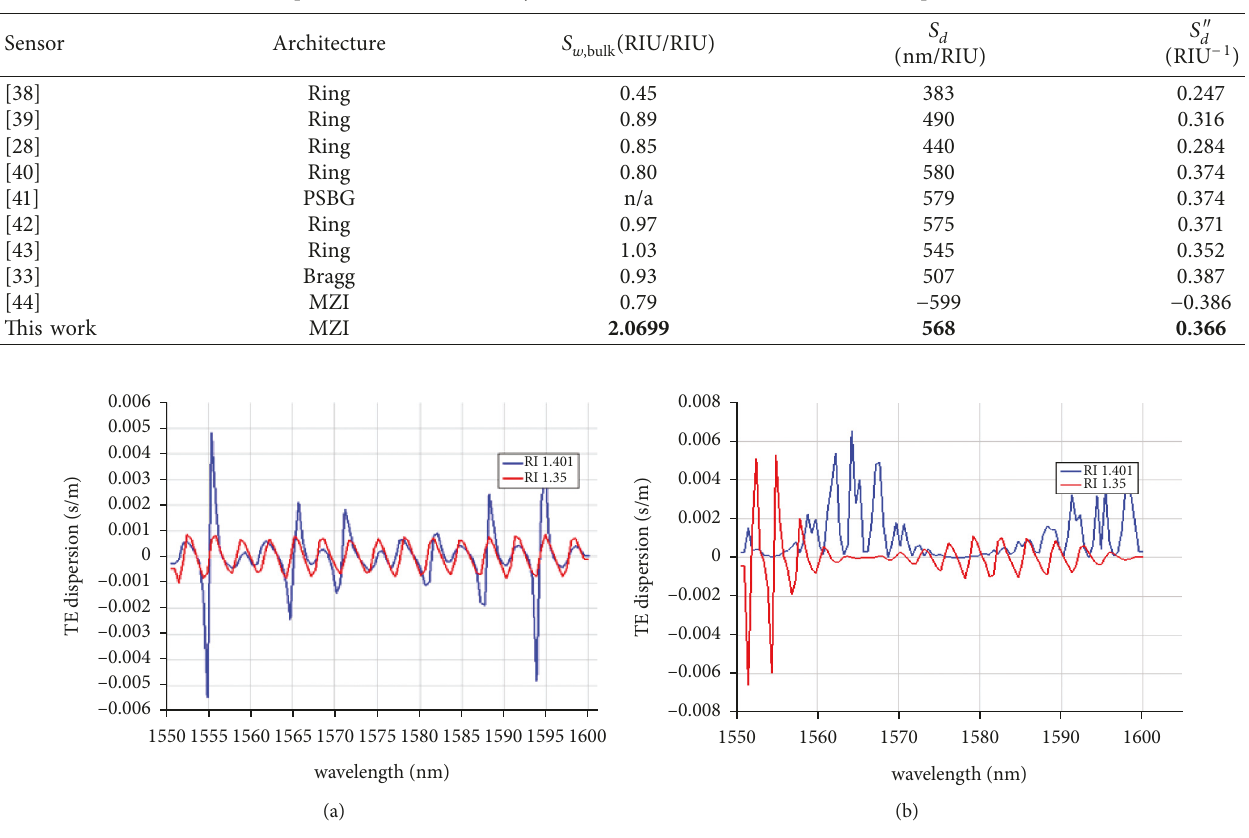
Figure 7: Dispersion of RI 1.35 normal cells and 1.401 cancer cells: (a) rib waveguide and (b) rib-slot